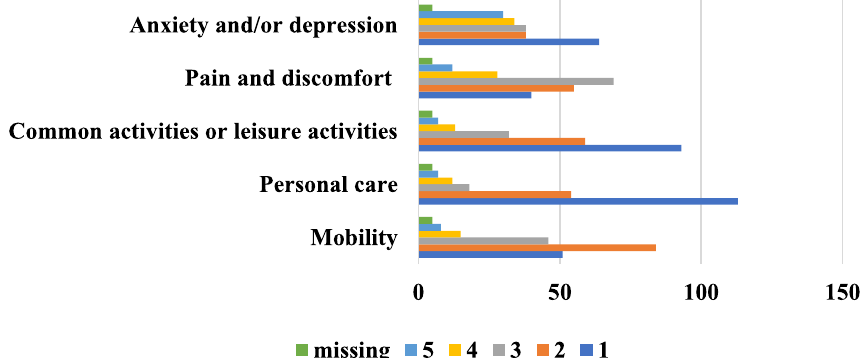
Fig. 1 Distribution of health-related quality of life measures in hemodialysis patients